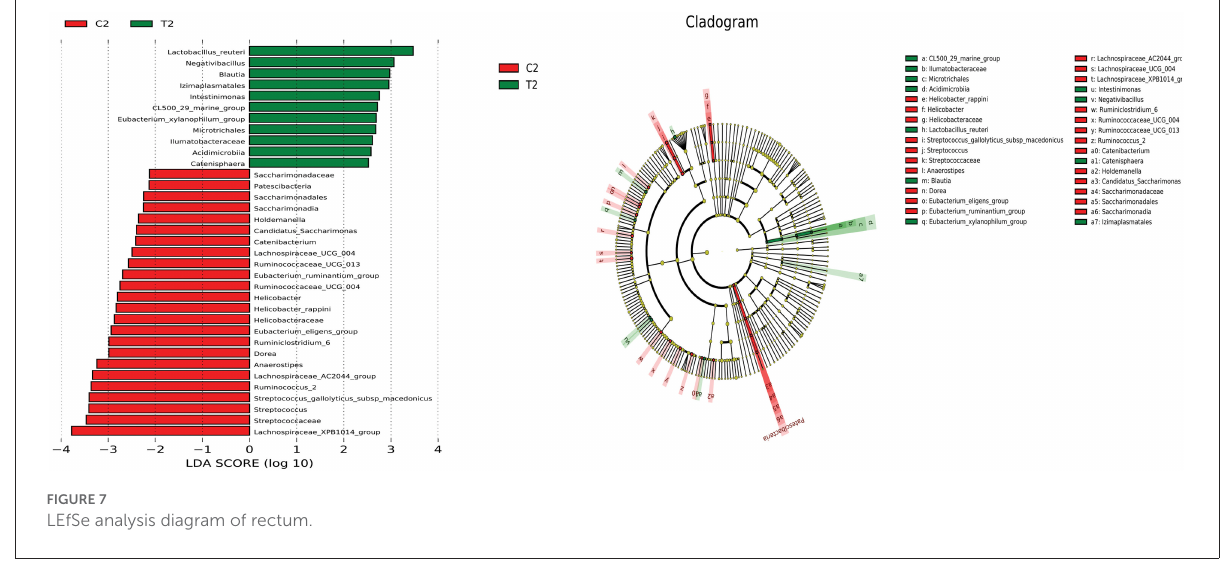
FIGURE7 LEfSe analysis diagram of rectum.